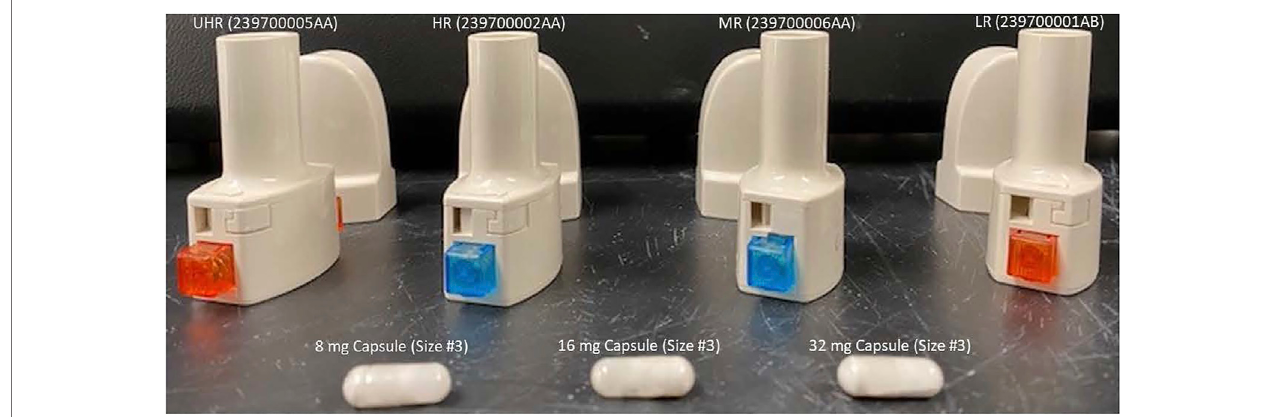
FIGURE 1 | Picture of the four RS01 devices evaluated with size three capsules containing TPIP.